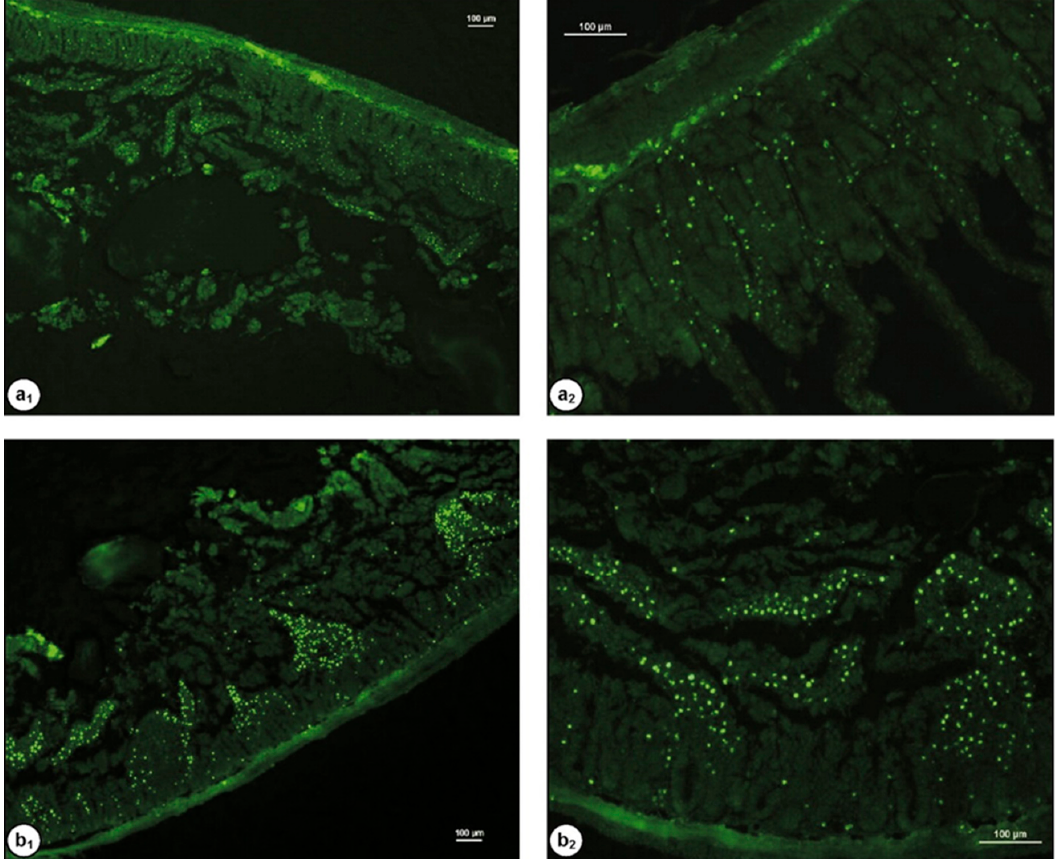
Figure 9. Fluorescent images of rat intestinal tissues after 2 h incubation with 100 µL (0.5% w/v ) chitosan ( a ) and chitosan-TBA ( b ) nanoparticles labelled with Alexa Fluor 488, (a 1 and b 1 ,40×; a 2 and b 2 , 100× magnification). The scale bars = 100 µm. Reprinted from [99] with permission of Elsevier.